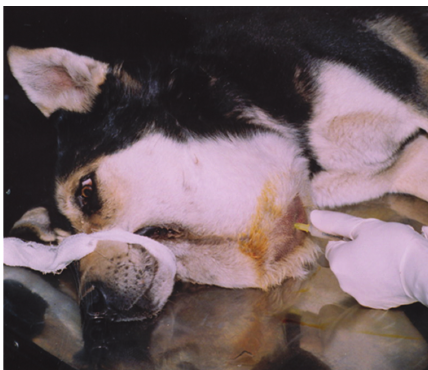
Figure 1: Aspiration of the cervical swelling under aseptic condi- tions. Note the extent and size of the swelling in the cervical and intermandibular region.